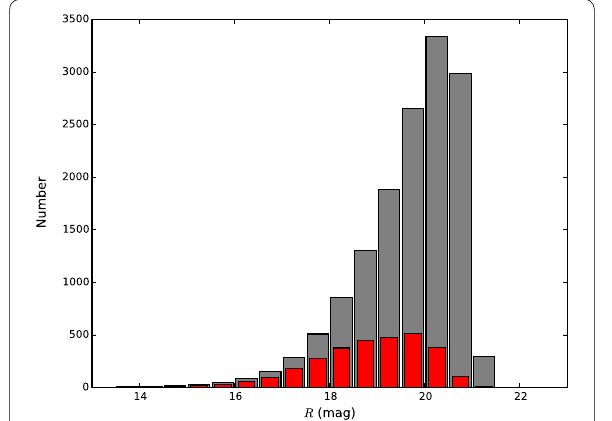
Fig. 1 Magnitude distribution of the PTF‑detected asteroids. Gray the PTF‑detected asteroids. Red the PTF‑U2s. This figure is reproduced from Chang et al. (2015, 2016)